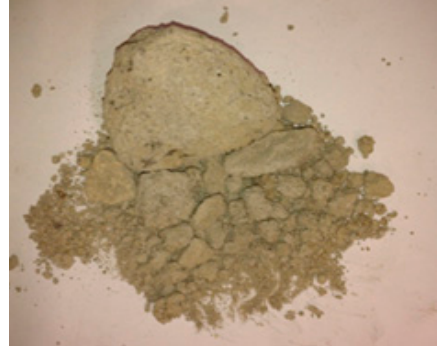
Figure 3. Air-cooled blast furnace slag.